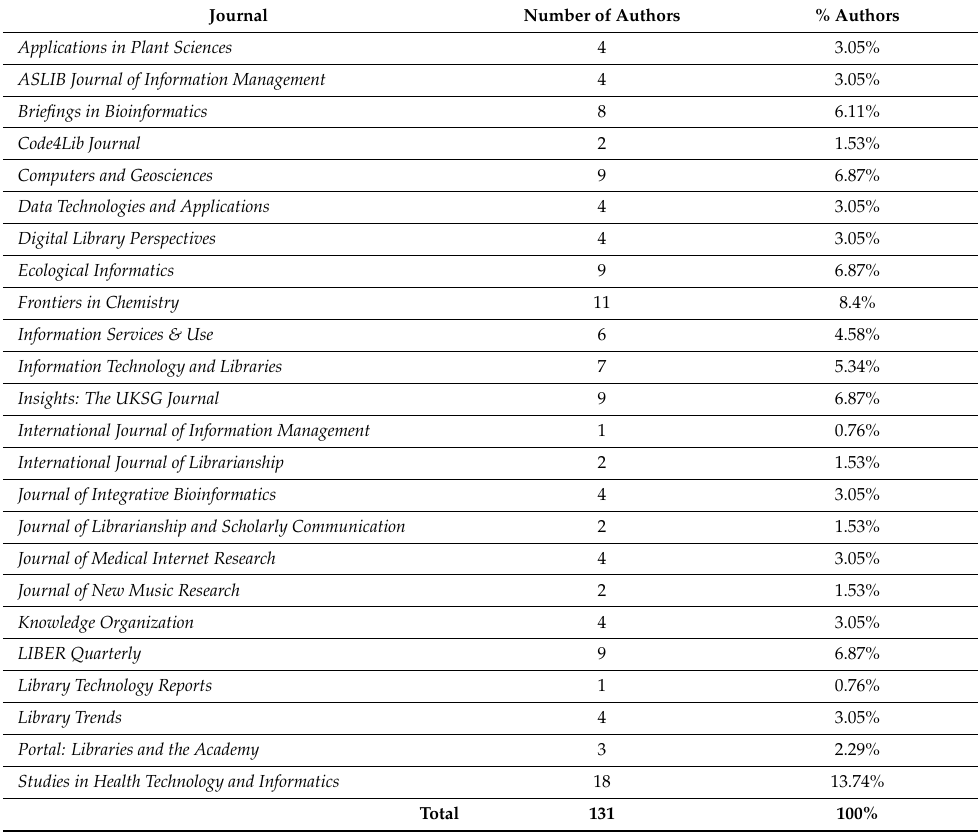
Table A7. Number of authors per